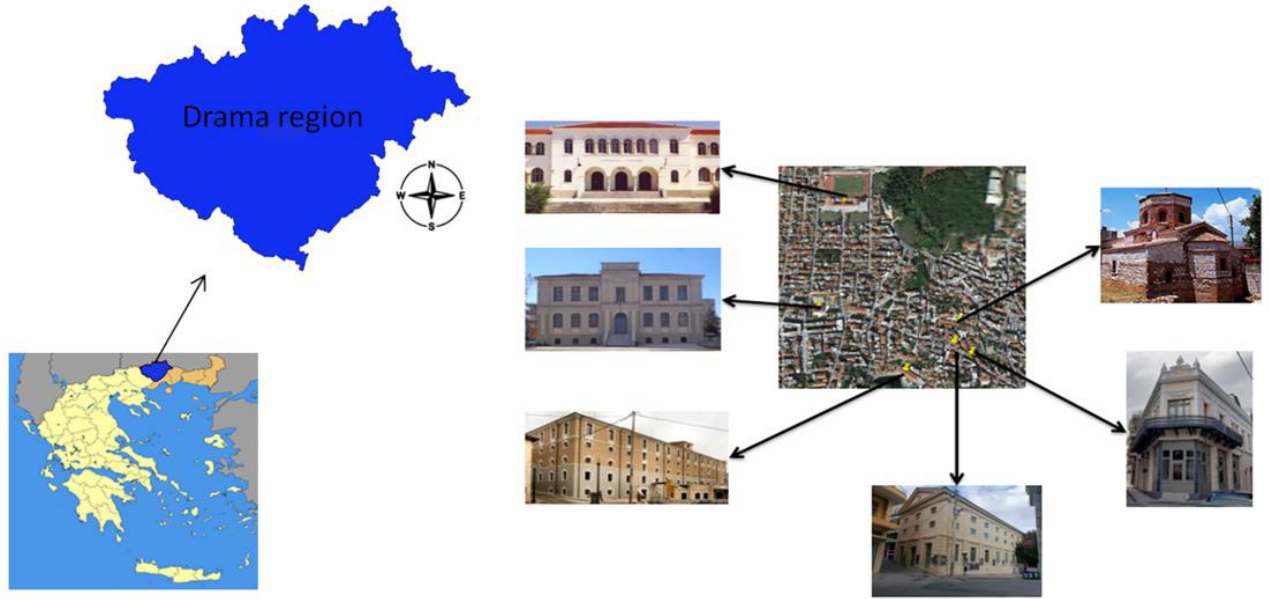
Figure 6. The study area is a part of Drama city. In the smaller map of Greece is the location of Drama, while the yellow pins represent the four landmarks that were used in this study.